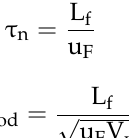
Figure 8. L f over ( A ) working fluid Re = [ 2000 − 3750 ] at